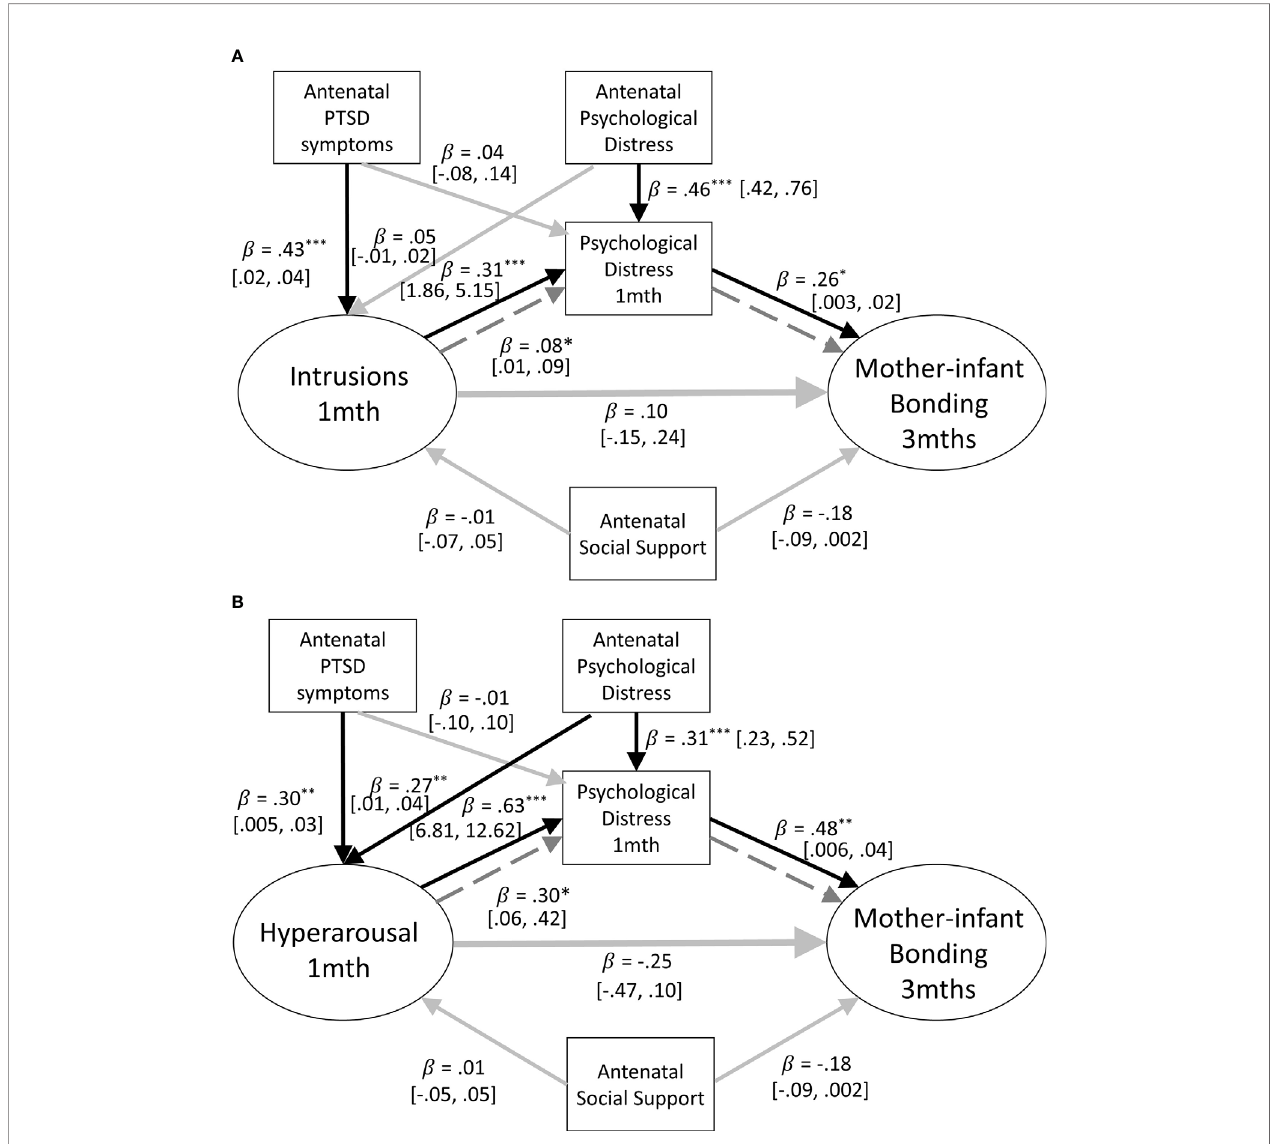
FIGURE 5 | (A) Path model of the mediation of the relationship between mother-infant bonding at 3 months and postpartum intrusion symptoms at one month by concurrent psychological distress. Antenatal social support and PTSD symptoms are also included as covariates. Black lines indicate signi fi cant pathways, grey lines indicate non-signi fi cant pathways, dashed lines sign fi y the indirect effect. Standardized coef fi cients and 95% con fi dence intervals are reported. ppPTSD, Postpartum Post Traumatic Stress Disorder. *p < .05; **p < .01; ***p < .001. (B) Path model of the mediation of the relationship between mother-infant bonding at three months and postpartum hyperarousal symptoms at one month by concurrent psychological distress. Antenatal social support and PTSD symptoms are also included as covariates. Black lines indicate signi fi cant pathways, grey lines indicate non-signi fi cant pathways, dashed lines sign fi y the indirect effect. Standardized coef fi cients and 95% con fi dence intervals are reported. PTSD-CB, Childbirth-related Posttraumatic Stress. *p < .05; **p < .01; ***p <